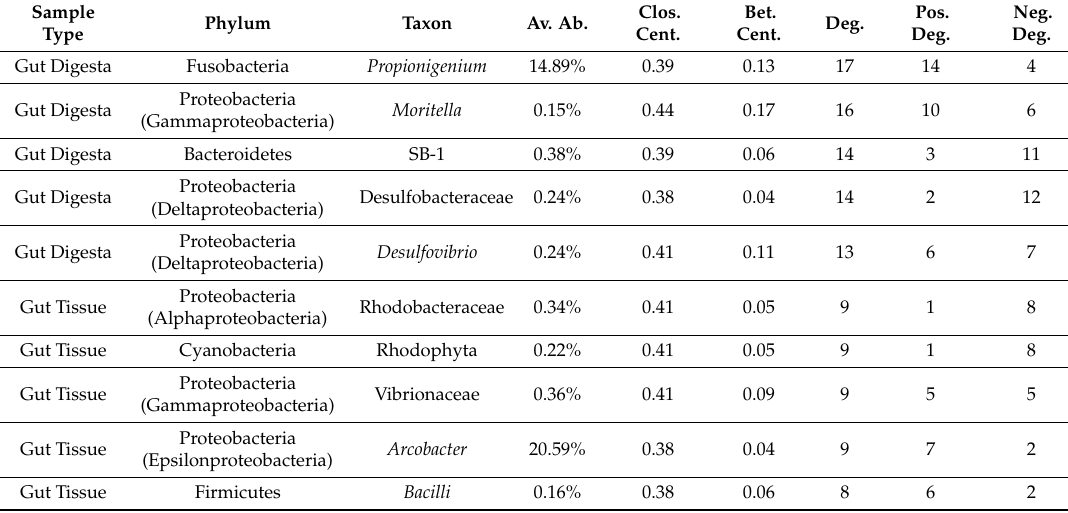
Table 3. Candidate key taxa resulting from CoNet (v1.1.1) analysis between the gut tissue and gut digesta microbial communities. The group assignment is shown (gut tissue, n = 3; gut digesta, n = 3), along with the phylum and taxon at the highest resolution. The average abundance (Av. Ab.) was determined for each taxon based on the respective group (gut tissue or digesta as indicated). The entries were ranked according to closeness centrality (Clos. Cent.), highest to lowest (a feature of keystoneness), and then by degree (edges; Deg.), highest to lowest. Also shown is the betweenness centrality (Bet. Cent.), and the total, positive (co-presence; Pos. Deg.) and negative (co-exclusion; Neg. Deg.) degree